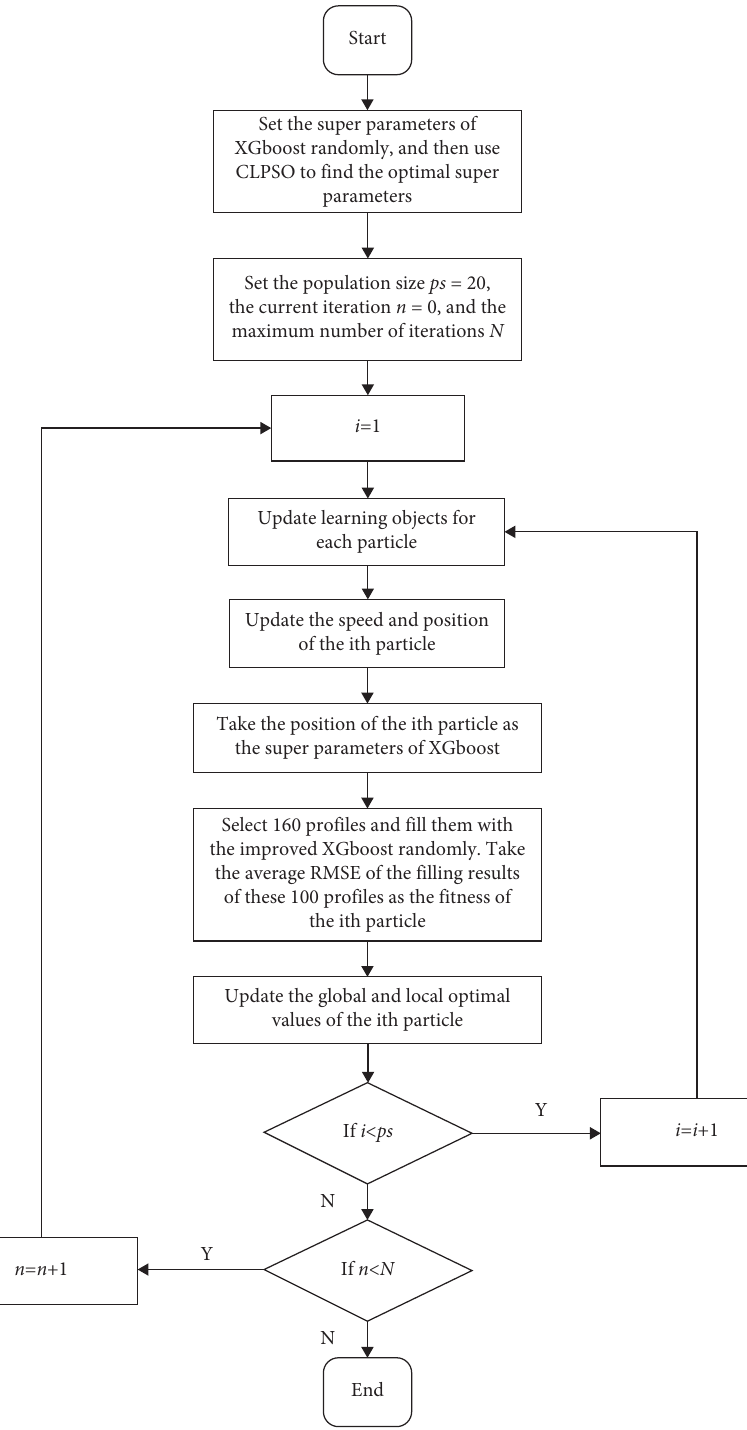
Figure 3: Flowchart of CLPSO